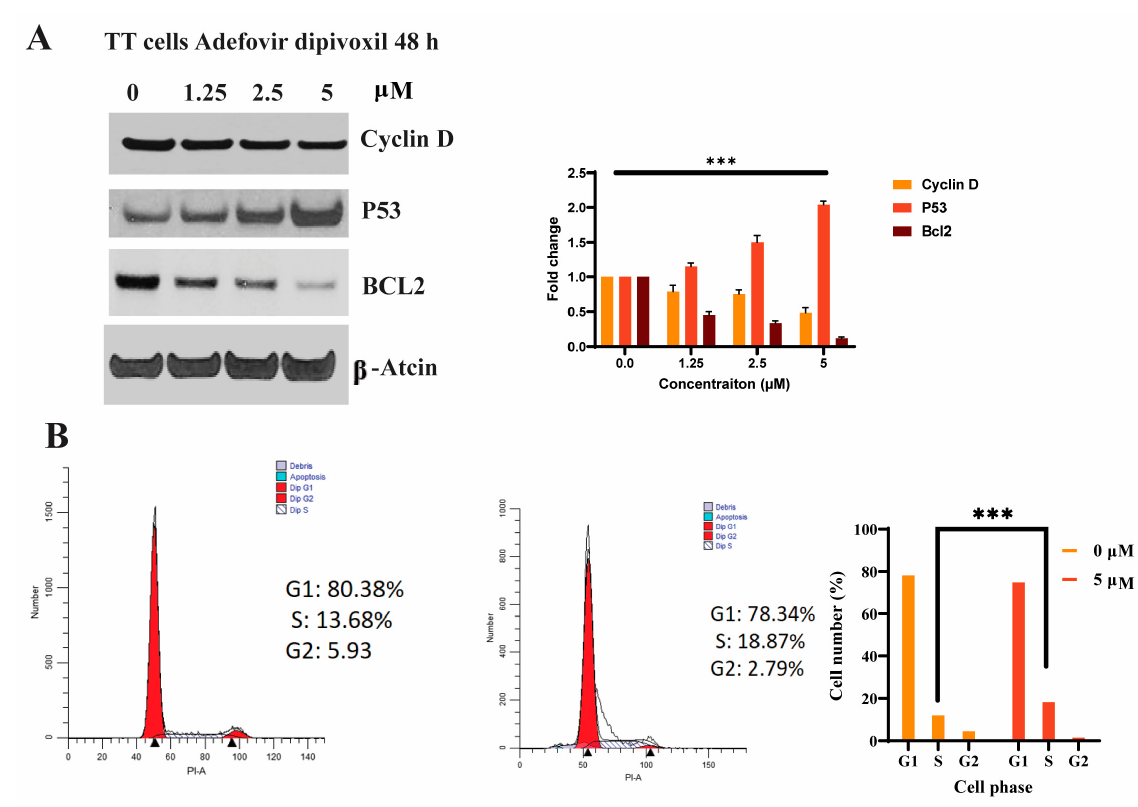
Figure 8. Cell cycle analysis for TT cells after adefovir dipivoxil treatment. ( A ) Expression of Cyclin D, P53, and Bcl2 in TT cells after 48 h adefovir dipivoxil treatment. The western blotting results for Cyclin D, P53 and BCL2 were quantified by densitometric analysis with normalization to basal expression, and differences among groups were analyzed using one-way ANOVA ( n = 3; *** p ≤ 0.001). ( B ) Flow cytometry cell cycle analysis using propidium iodide DNA staining in untreated and adefovir dipivoxil-treated cells. The cell cycle data are mean +/ − SEM of three different experiments and the differences among groups were analyzed by one-way ANOVA with Tukey’s post hoc test (*** p ≤ 0.001). The uncropped blots are shown in Figure S8.